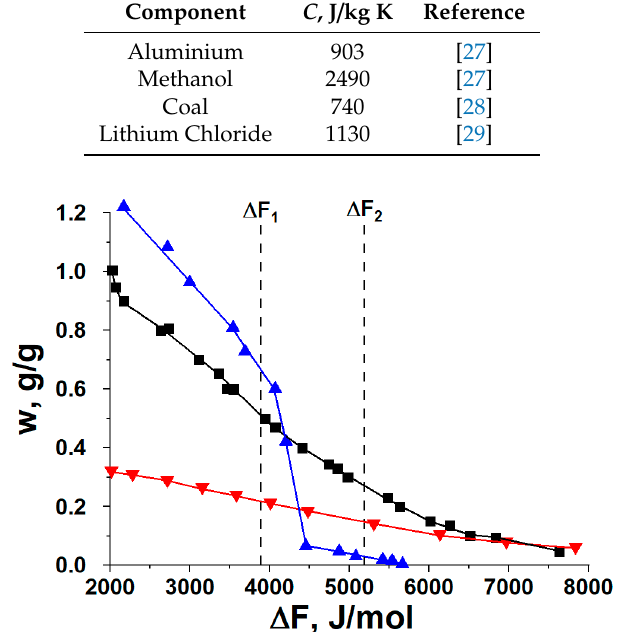
Table 2. Specific heat capacity C of inert components of the analyzed adsorbent–heat exchanger (AdHEx). Table2. Specificheatcapacity C ofinertcomponentsoftheanalyzedadsorbent–heatexchanger(AdHEx).